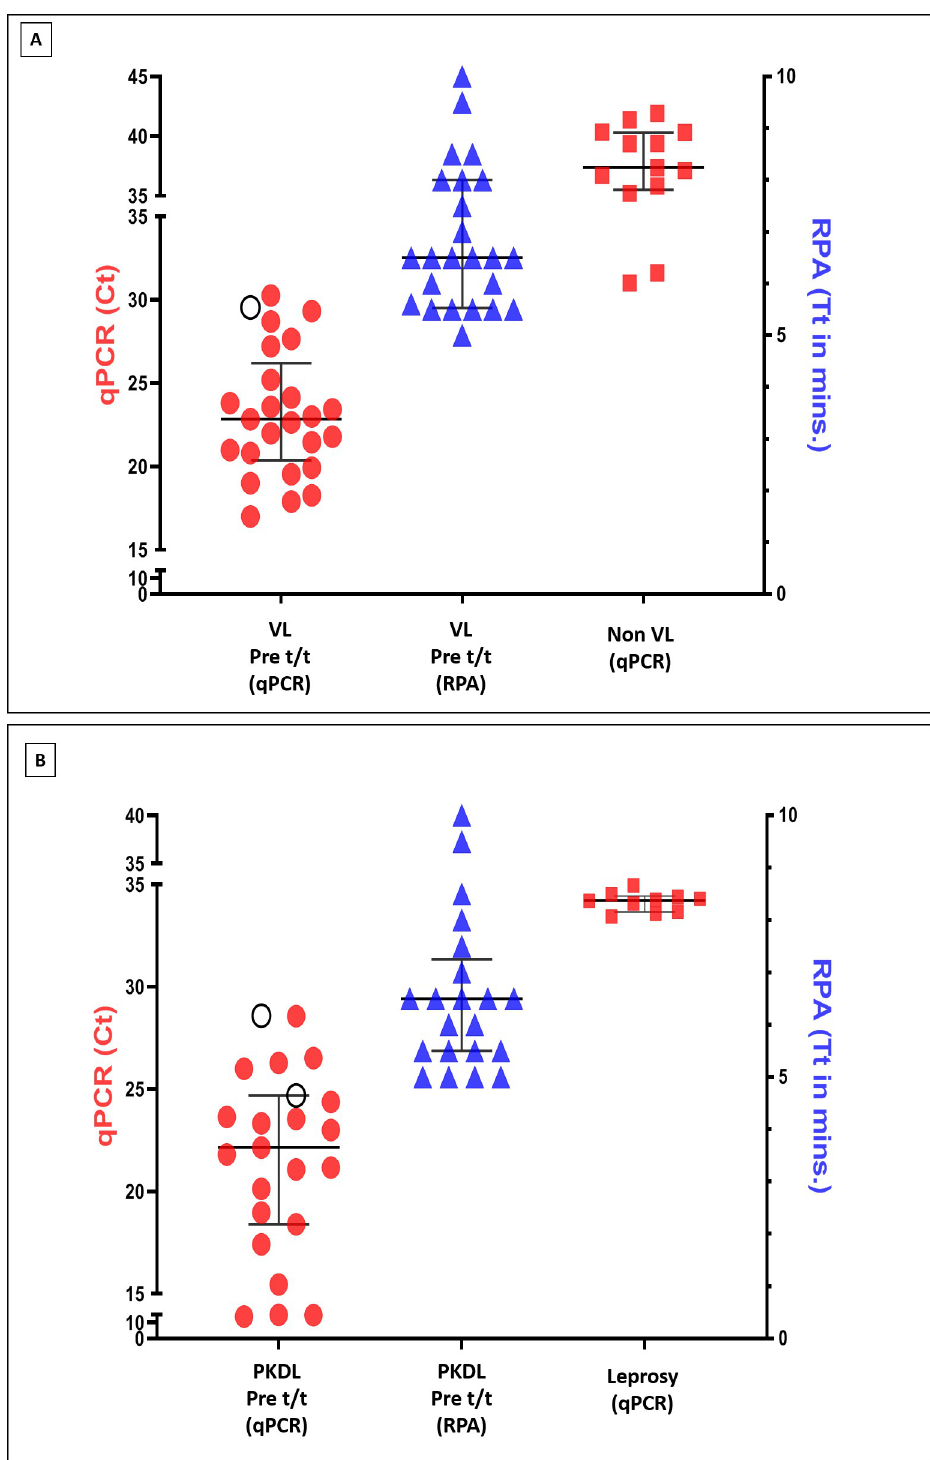
Fig 3. Diagnostic performance of qPCR vis-à-vis RPA assays in VL and PKDL cases. A. Diagnosis of patients with VL in qPCR vs. RPA assays . Scatterplots from qPCR ( ● ) and RPA ( ▲ ) showing cycle threshold (Ct) and time threshold (Tt) performed in peripheral blood sourced from patients with VL (na ï ve cases, n = 25) and non VL cases (n = 14, ■ ), as described in materials and methods. Each horizontal bar represents the median (IQR) value; ( � ) represents a qPCR positive sample that was not detected by RPA. The RPA negative sample had a Tt > 10 minutes and